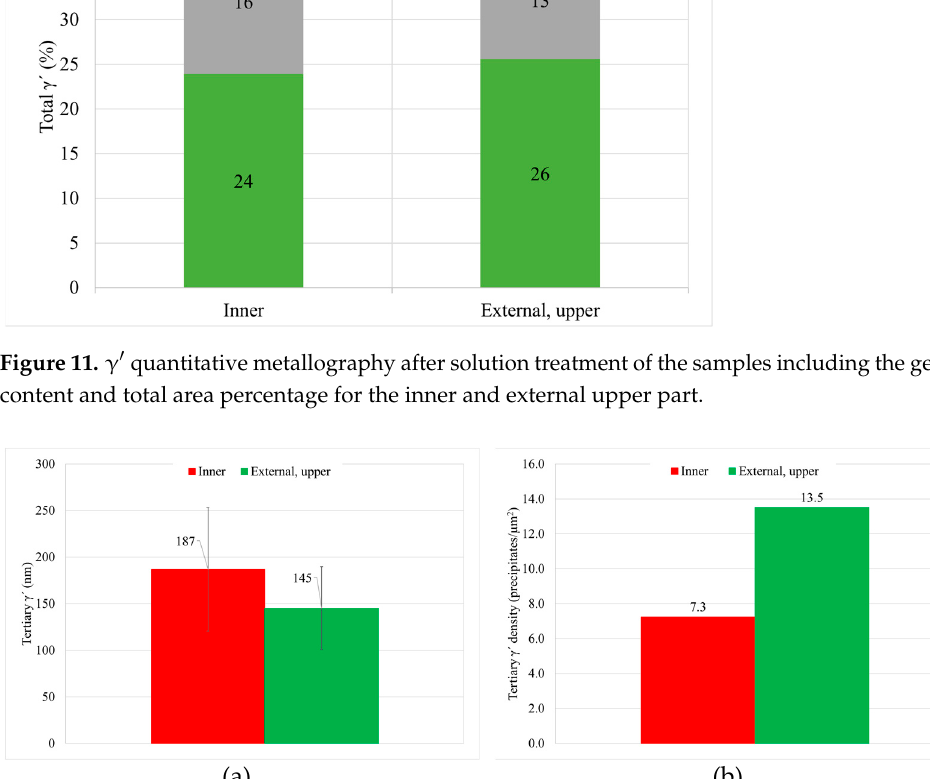
Figure 12. Tertiary γ′ ( a ) size and ( b ) density of precipitates after solution treatment in the inner and external upper part of the can.